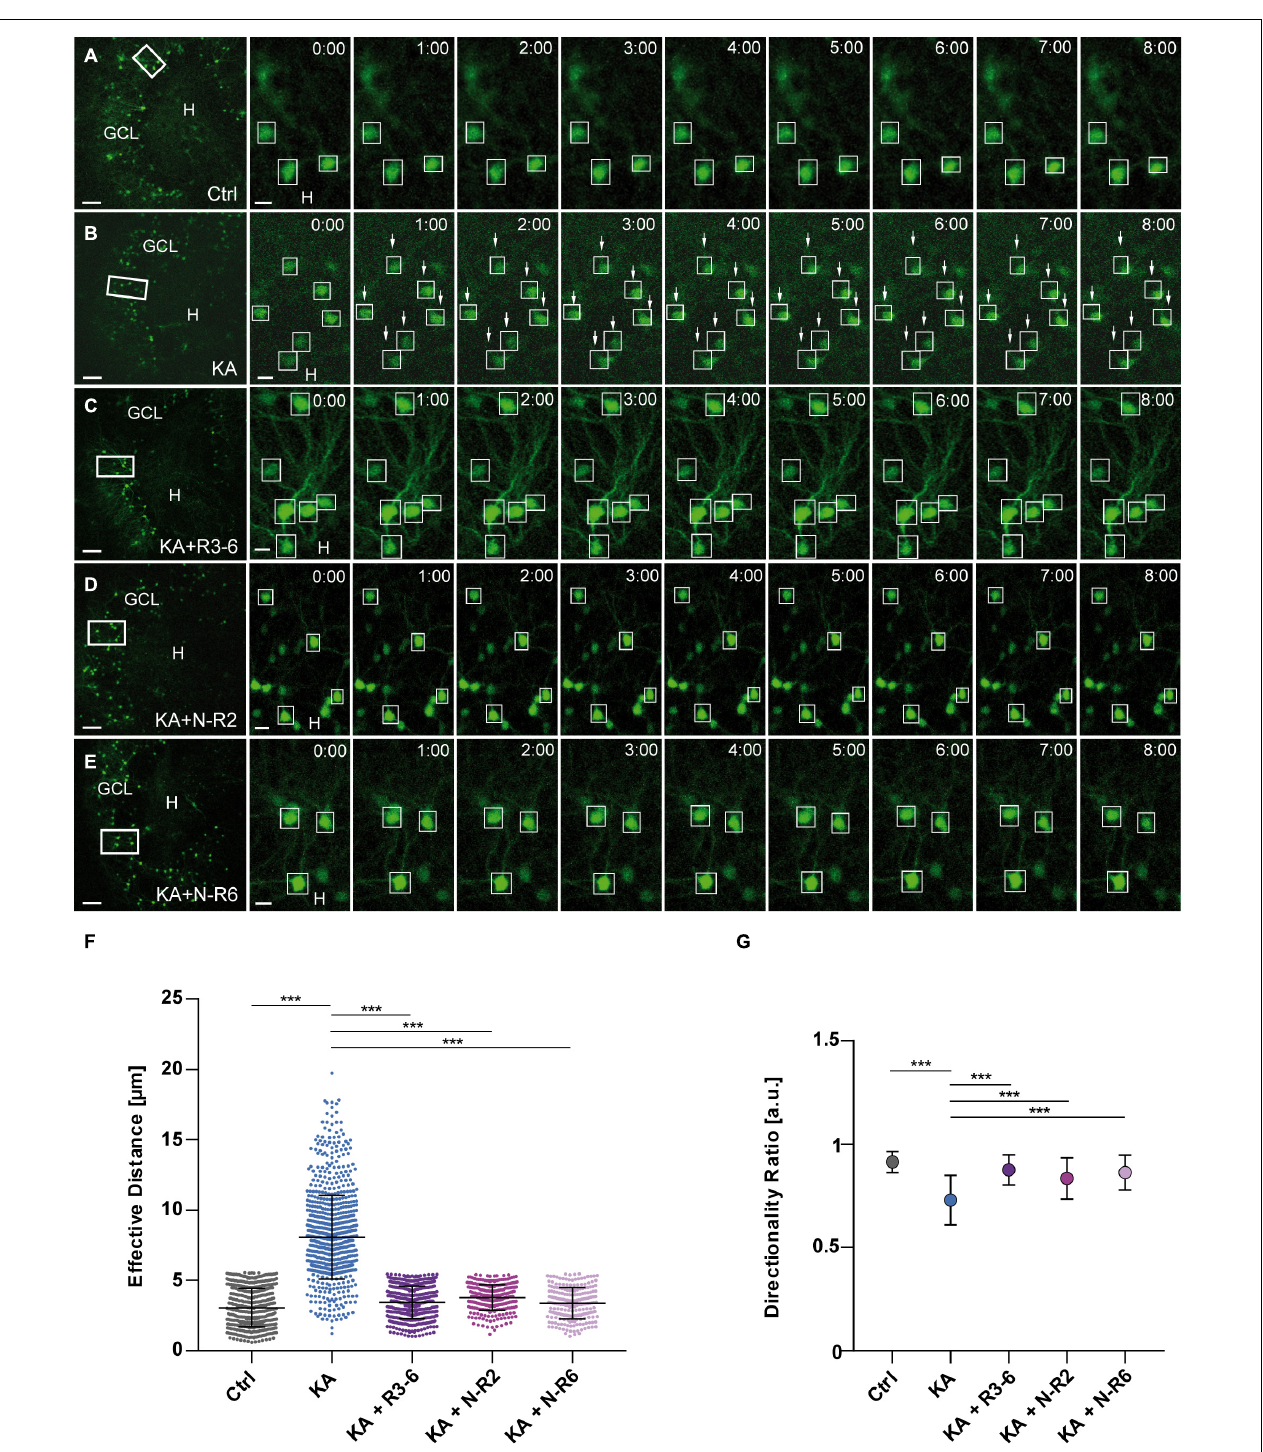
FIGURE 3 | KA-induced migration of differentiated GCs is prevented by recombinant Reelin fragments. (A–E) Live cell imaging of individual eGFP-positive GCs was performed over a period of 8 h, and migration distances of automatically selected cells were assessed. Representative confocal micrographs of nine imaging time points are shown for each condition. Left panel: overview; white frame indicates the area shown at high magnification on the right. Tracked cells are marked by white frames. (A) Untreated control ( n = 23 slices, 548 cells). GCs do not change their position. In all experiments, each slice derived from a different animal. (B) Treatment of OHSC with 10 µ M KA for 45 min ( n = 20 slices, 868 cells). GCs with high motility are indicated by